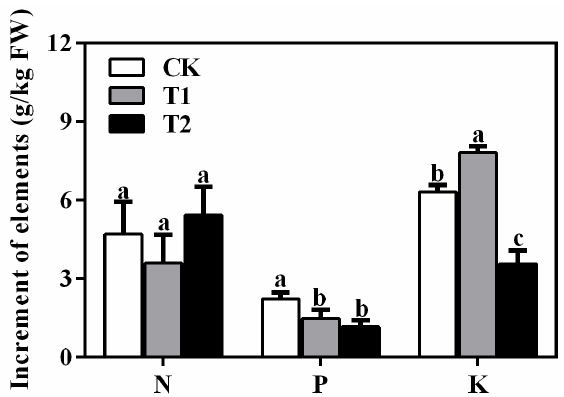
Figure 6. Increment of N, P, K elements in leaves of ‘Misty’ in a plant factory with artificial lighting. Notes: The data are the mean value of three replicates, and the bar indicates the standard deviation. Different letters indicate significance at p ≤ 0.05 based on Duncan’s multiple range tests.